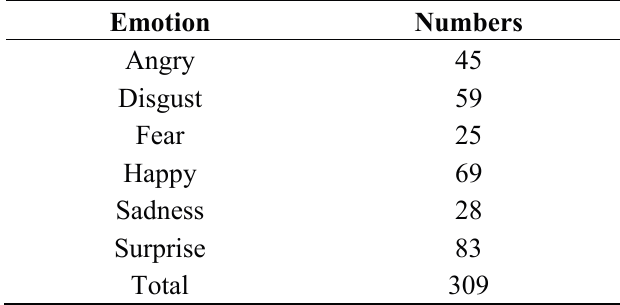
Table 1. Number of each basic expression’s sequences.